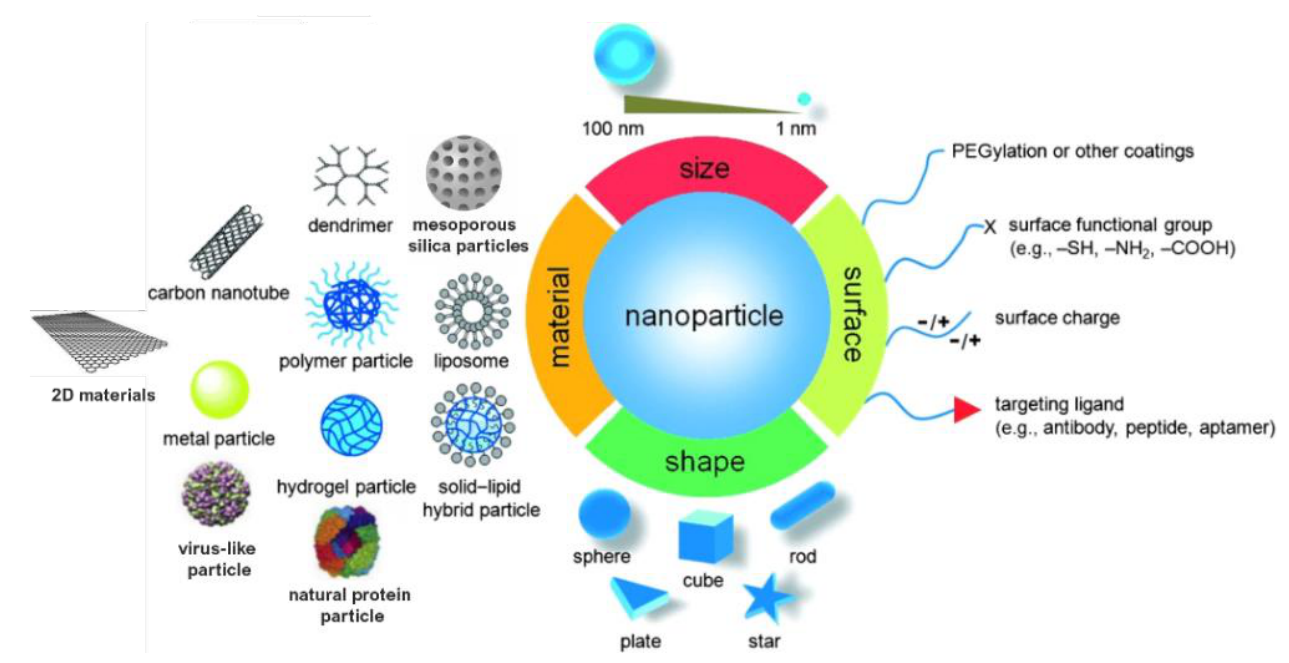
Figure 1. Material, shape, size and surface properties play an important role on the biophysicochemical properties of nanoparticles. Adapted from [10] and [11]. Copyright © 2022 WILEY‐VCH Verlag GmbH and Co. KGaA, Weinheim.